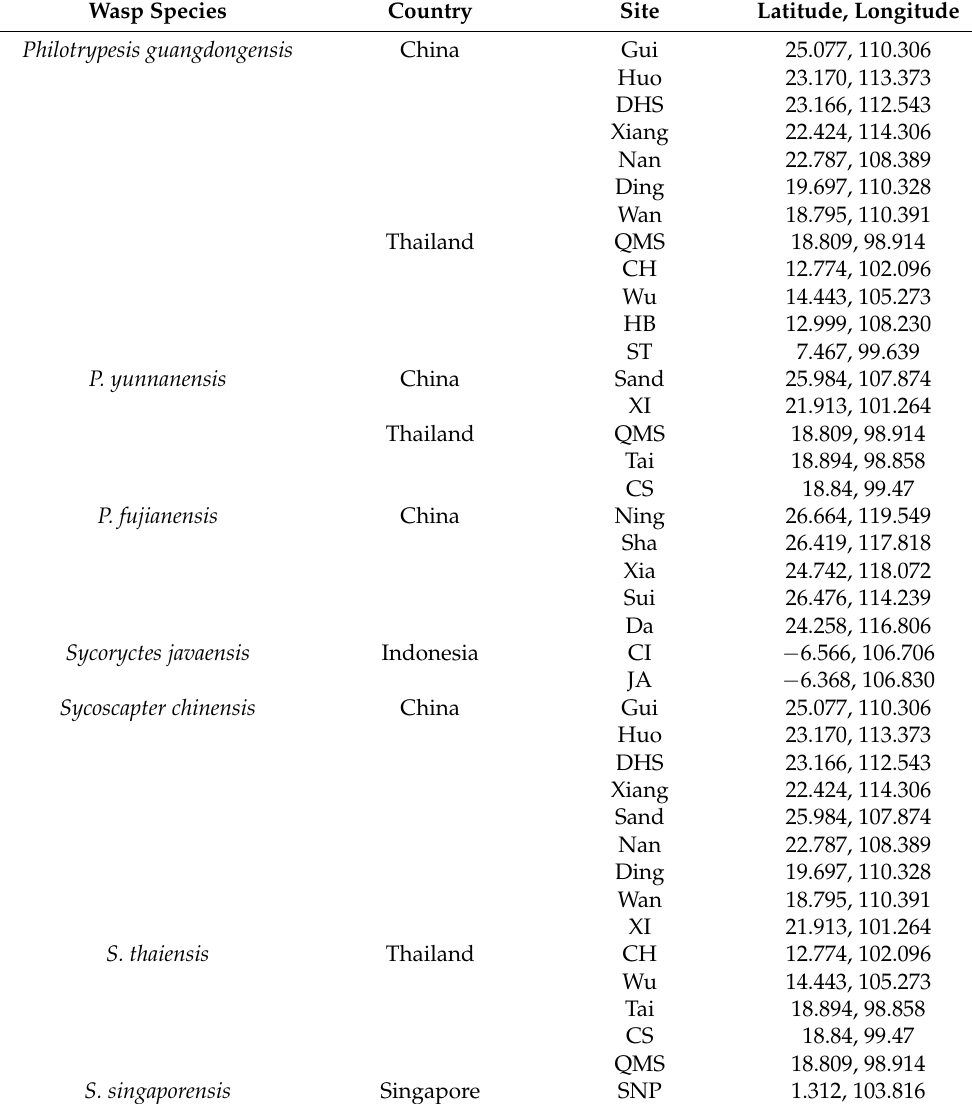
Table 1. Sampling sites for sycoryctine fig wasps associated with Ficus hirta